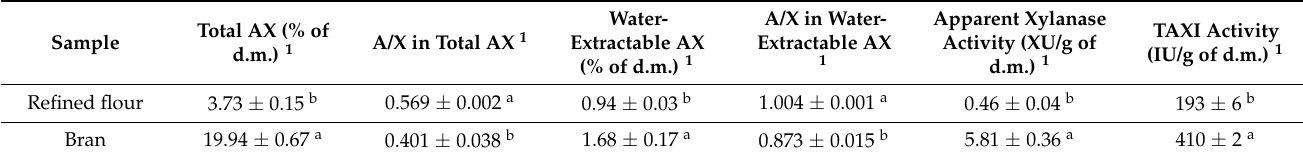
Table 5. Contents and arabinose to xylose ratio (A/X) of arabinoxylan (AX) populations, and activities of endogenous xylanase and Triticum aestivum xylanase inhibitor (TAXI) in refined flour and bran from intermediate wheatgrass on a dry matter (d.m.)